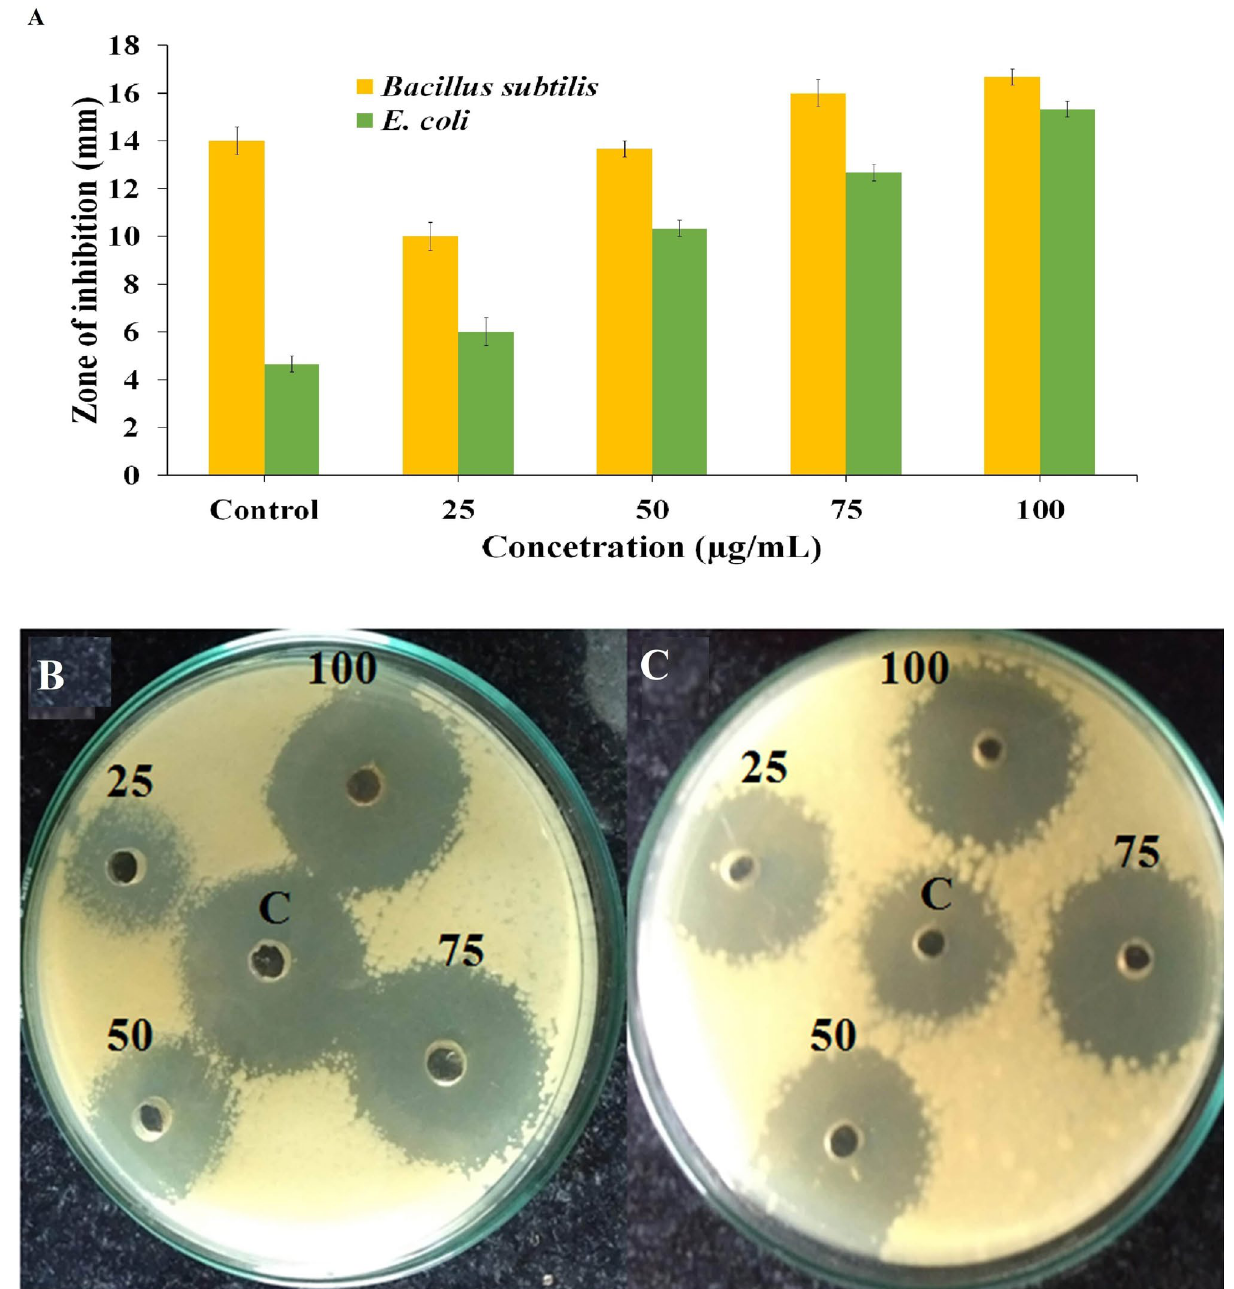
Figure 10. ( A ) The antibacterial activity of SeNPs on different pathogenic bacteria ( B. subtilis and E.coli ) at different concentration (25, 50, 75, and 100 µg) and control antibiotic methicillin (The zone of inhibition values are expressed as mean ± SD and analyzed by one-way variance (ANOVA). Representative images of inhibition zones against clinical pathogens, ( B ) B. subtilis and ( C ) E. coli.